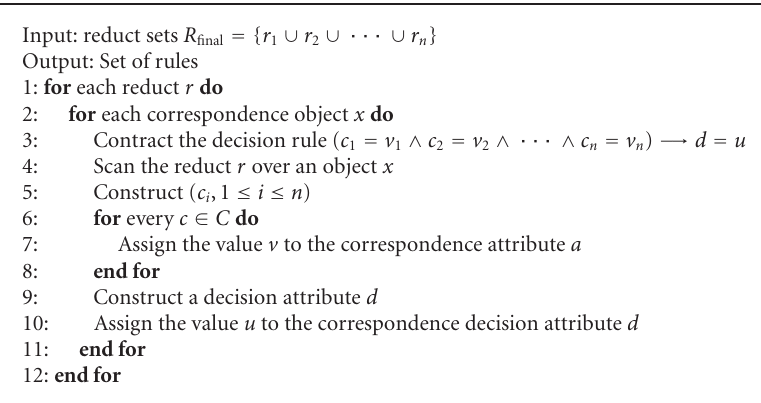
Algorithm 3: Rule generation and